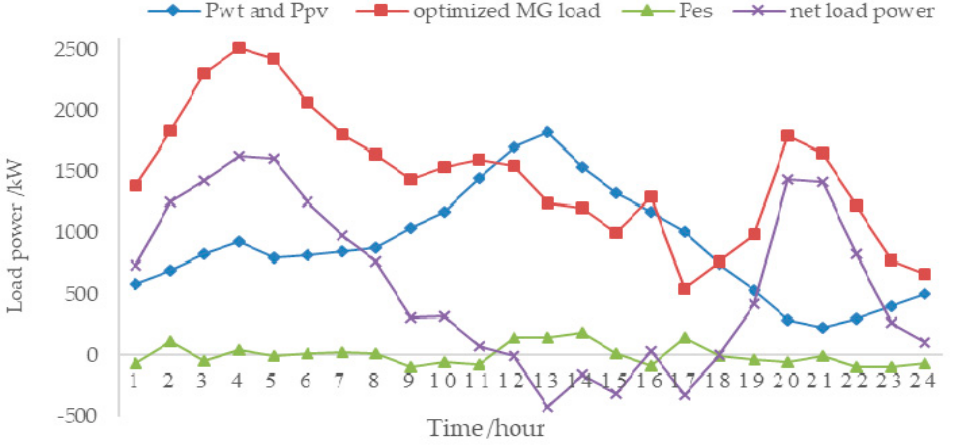
Figure 9. Pareto front of source-load level.